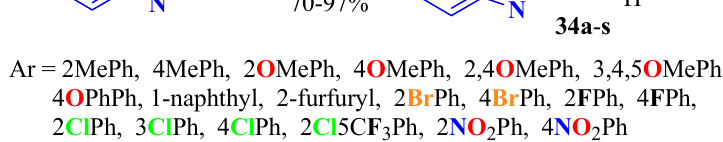
Scheme 15. Synthesis of aryl-UBTs from 2ABT and aryl-isocyanates.